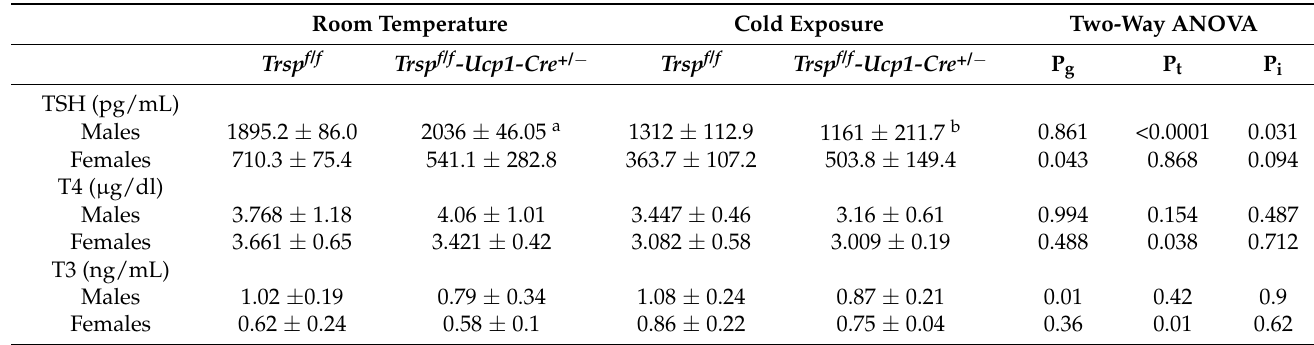
Table 5. Thyroid function of the Trsp f/f -Ucp1-Cre +/- mice.